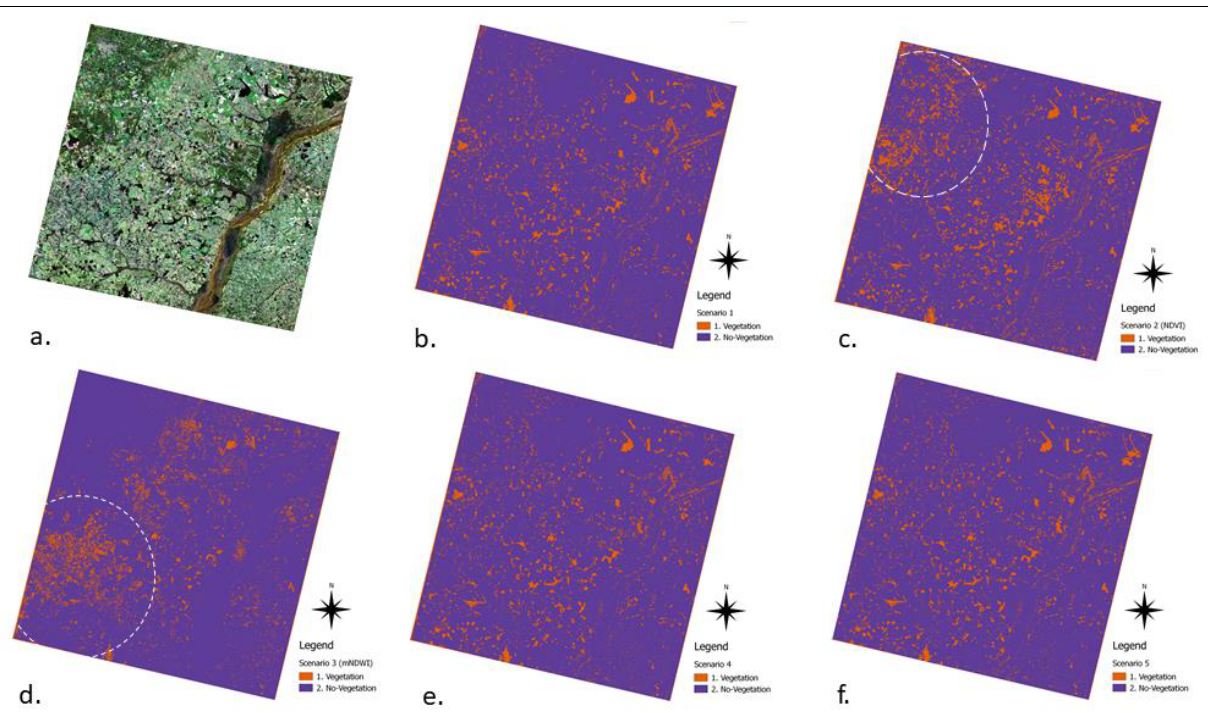
Figure 3: a. Image Landsat investigated, b. classification - scenario I, c. classification - Scenario II (NDVI), d. classification - scenario III (mNDWI), e. classification - scenario IV (I + II) and f. classification - scenario V (I + II+III).